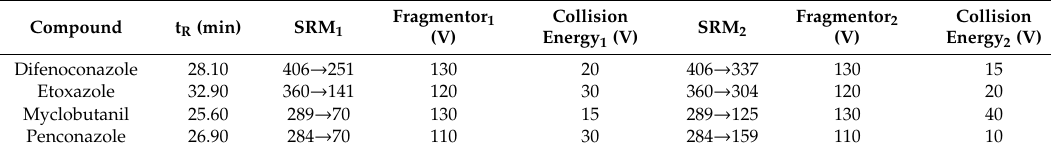
Table 4. Analytical conditions of the studied pesticides.